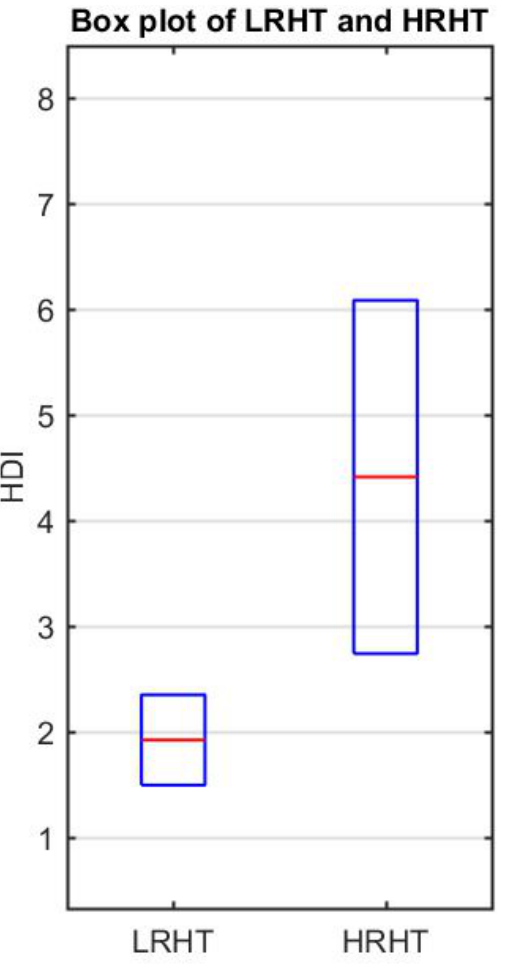
Figure 7. Box plot of LRHT and